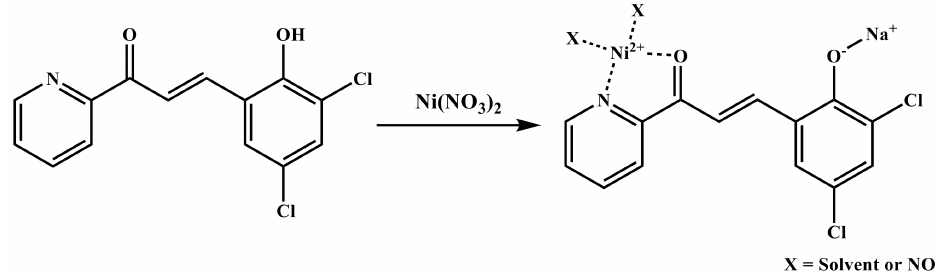
Scheme 1. Proposed feature of DPP -Ni 2+